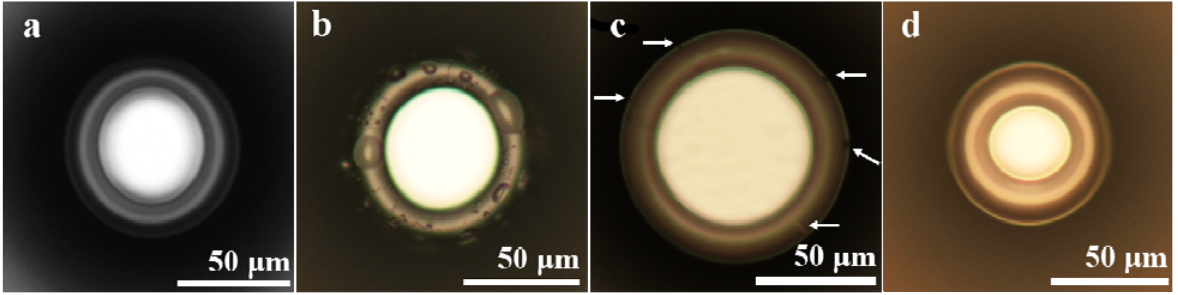
Figure 4. Optical micrographs of silica microtoroids. (a) As-fabricated microtoroid. (b) Microtoroid after piranha etch. (c) Microtoroid after piranha etch and 24 h drying at 100 ºC. The white circles indicate regions of structural damage. (d) Microtoroid after O plasma